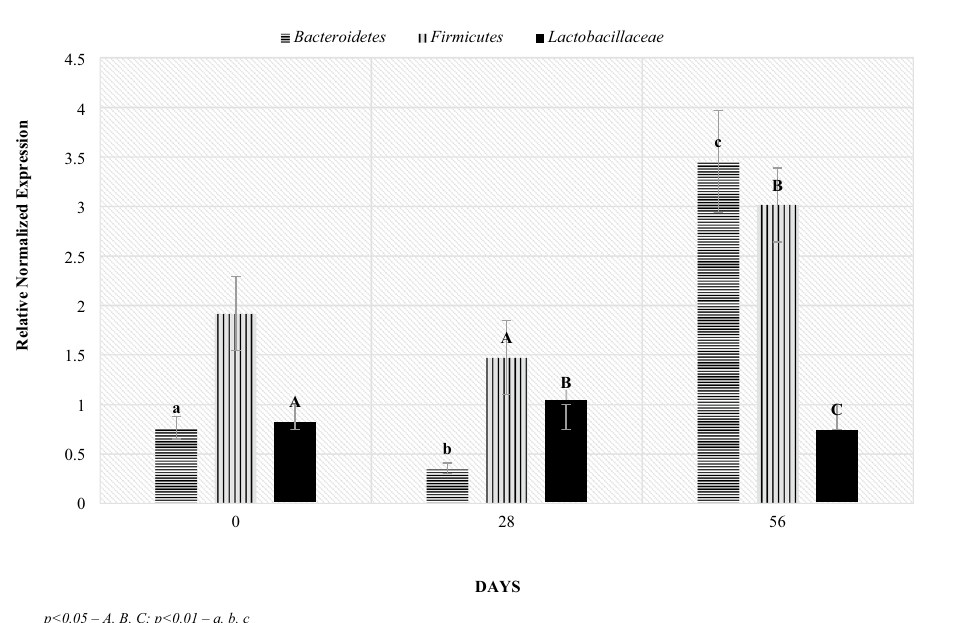
Figure 5. Level of Bacteroidetes (RNE) in ewes and lambs feces. p < 0.05—A, B, C; p < 0.01—a, b, c.